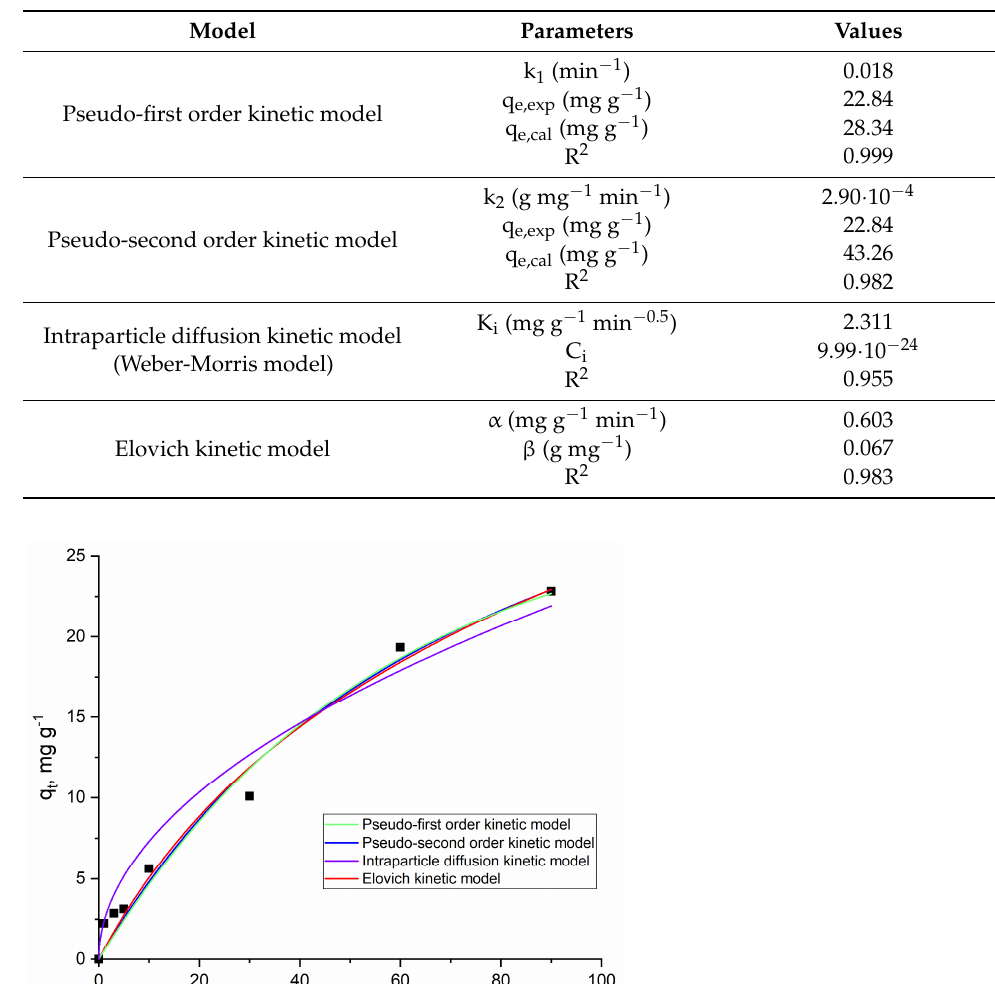
Table 1. Kinetic model parameters for copper ions biosorption onto eggshells. Model Parameters Values